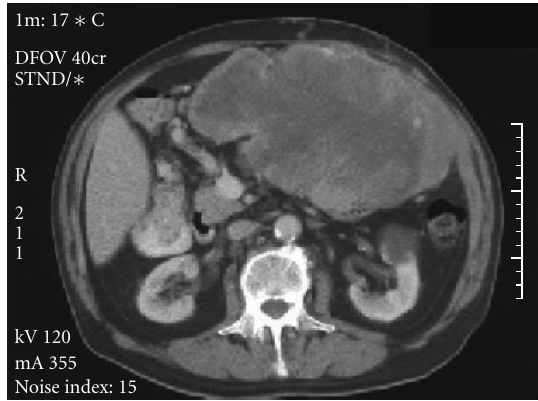
Figure 3: Computerised tomography scan of large abdominal mass measuring 20 × 11 ×